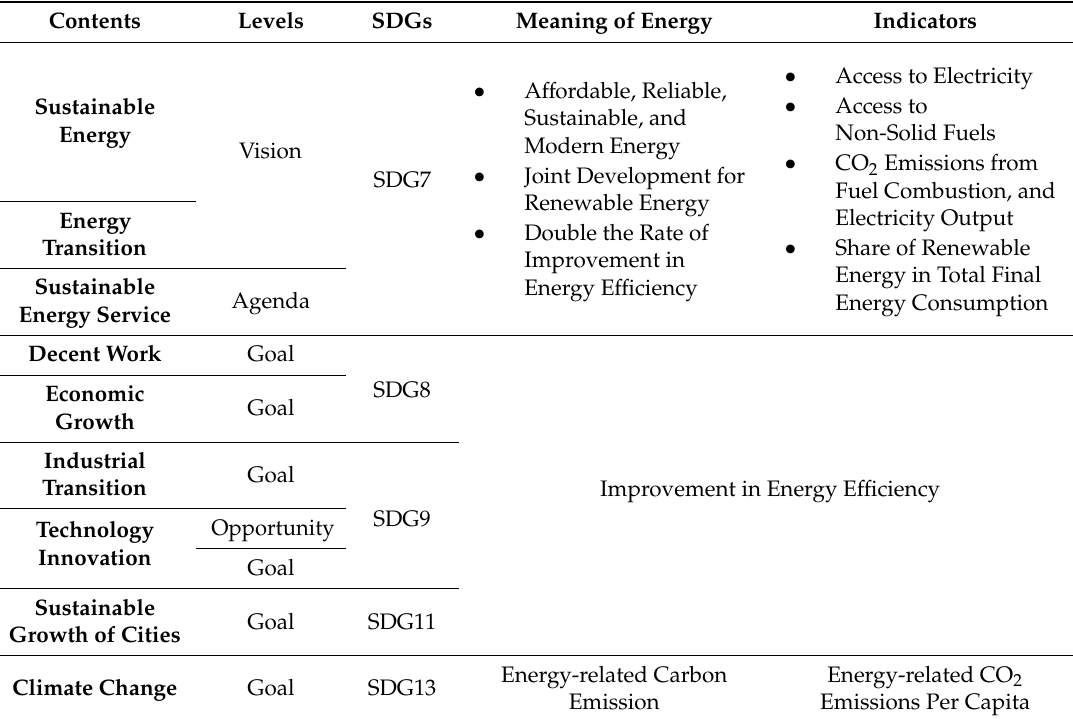
Table 1. The meaning of energy and its indicators in the 2030 Agenda for Sustainable